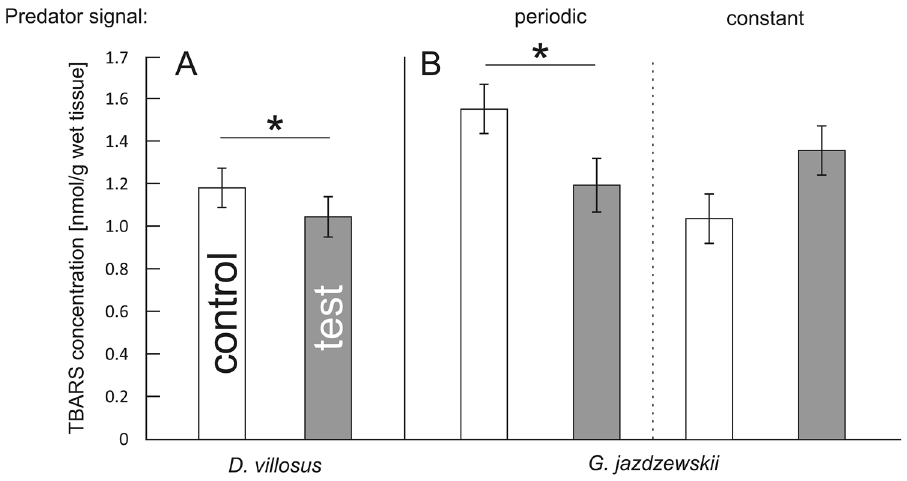
Figure 1. A correct version of the original Figure